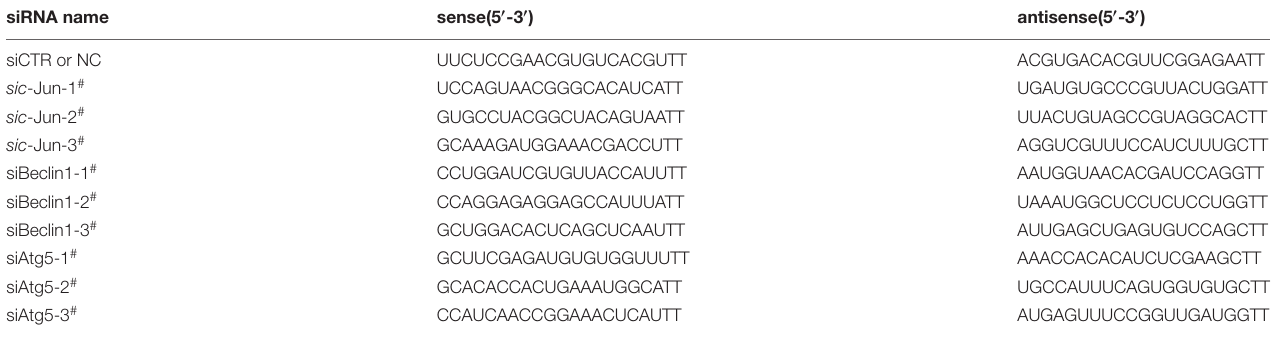
TABLE 2 | Sequences of siRNA for porcine negative control, c-Jun , beclin1 , and Atg5 . siRNA name sense(5 (cid:48) -3 (cid:48) ) antisense(5 (cid:48) -3 (cid:48)